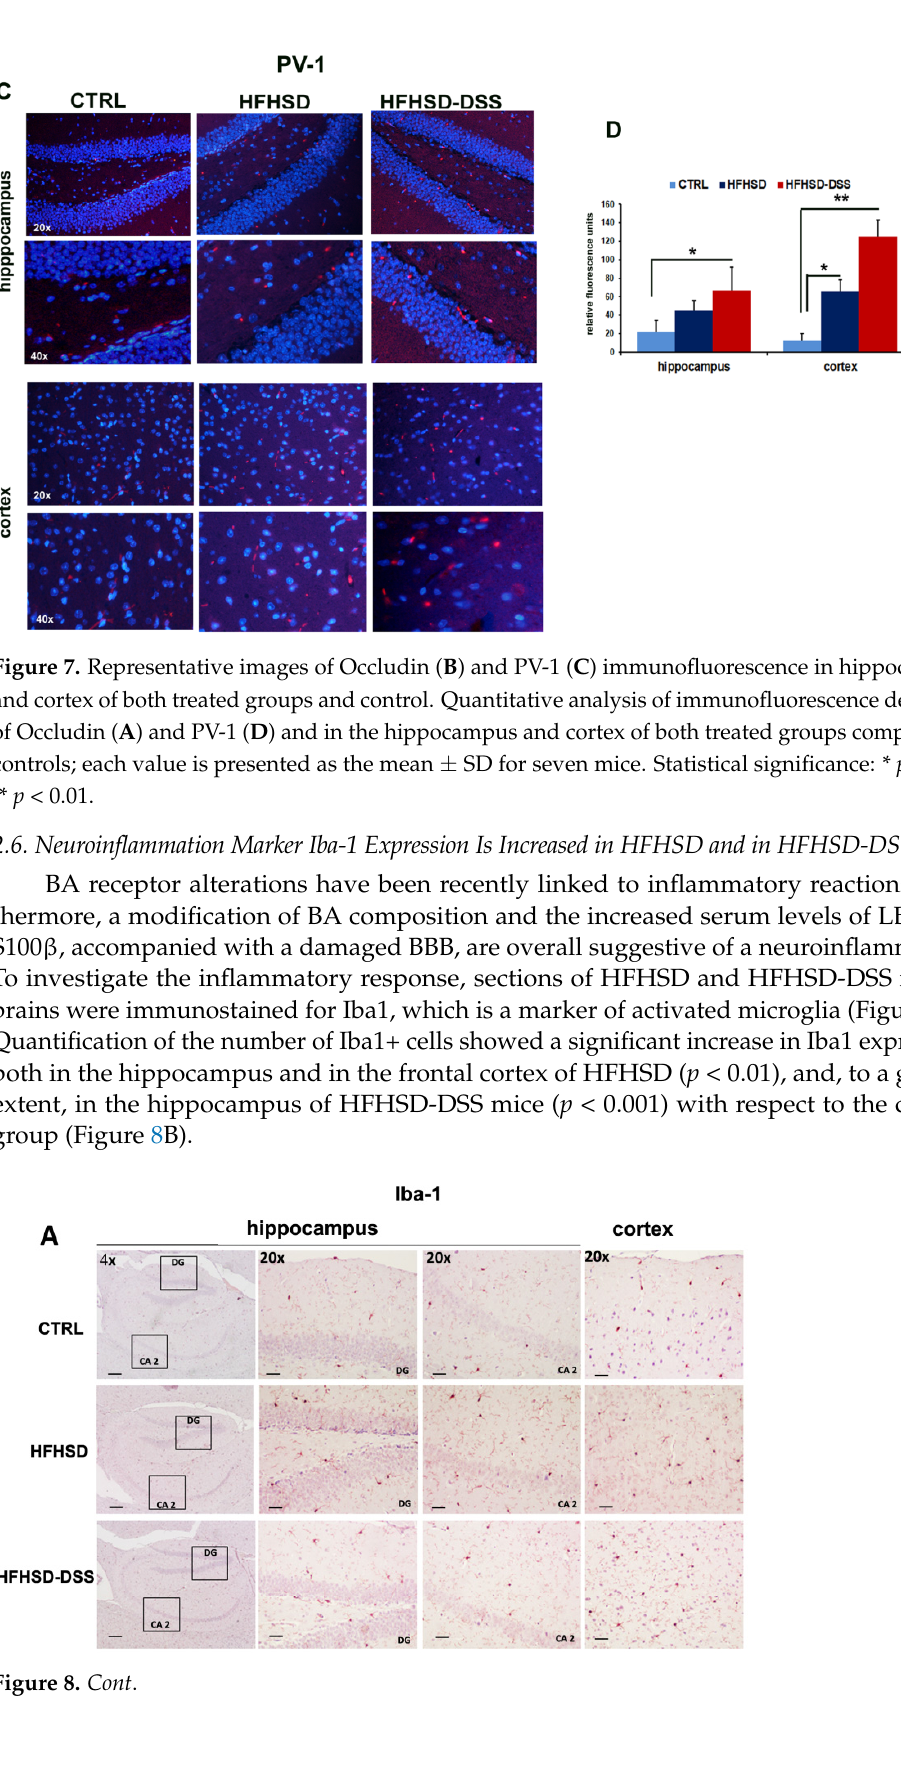
Figure 8. ( A ) Representative images of immunohistochemistry (IHC) staining of Iba-1 in different regions of the hippocampus and frontal cortex of treated mice as compared to control. 20× magni- fication: Scale bar = 25 μ m. 4× magnification: scale bar 100 μ m; ( B ) Quantitative analysis of stained nuclei/mm 2 . Each value is presented as the mean ± SD for seven mice. Statistical significance: ** p < 0.01; *** p < 0.001. 3. Discussion In our previous paper, we demonstrated that intestinal inflammation worsens liver injury induced by a high-fat and sugar diet, leading to the more severe condition of NASH and that the expression of BA receptors FXR and TGR5 is altered in inflamed in- testine and liver [24]. In the present study, we demonstrated that NAFLD and, furtherly, the more severe NASH, lead to brain dysfunction characterized by a modulation of BA receptors FXR and TGR5. These alterations are supposed to be induced by an imbalance of BA composition in serum, and they are favored by a systemic exposure to the bacterial endotoxin LPS. Both these conditions provoke a BBB destruction, which is assessed by ZO-1, Occludin, PV-1 and S100 β alterations, leading to neuroinflammation, as evaluated by measuring Iba-1 expression. More in detail, we found a significant down-regulation of nuclear FXR in the hip- pocampus and cortex of HFHSD-DSS mice as compared to the HFHSD and control groups, which is a variation that is consistent with inflammatory conditions. Indeed, FXR is known to be negatively regulated by inflammatory molecules as cytokines and pro-inflammatory transcription factors as NF- κ B [29]. On the contrary, we observed an up-regulation of cytoplasmic TGR5 expression, according with results reporting TGR5 overexpressed in the immune response, in activated macrophages and microglia (the